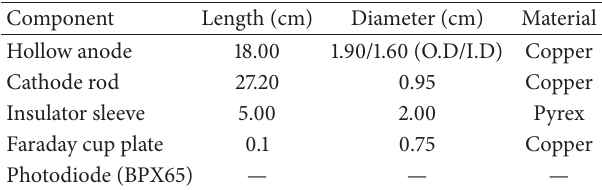
Table 1: Design parameters of plasma focus system. Table 2: An array of five PIN diodes exposed with Al foil plus aluminized Mylar ( 𝜇